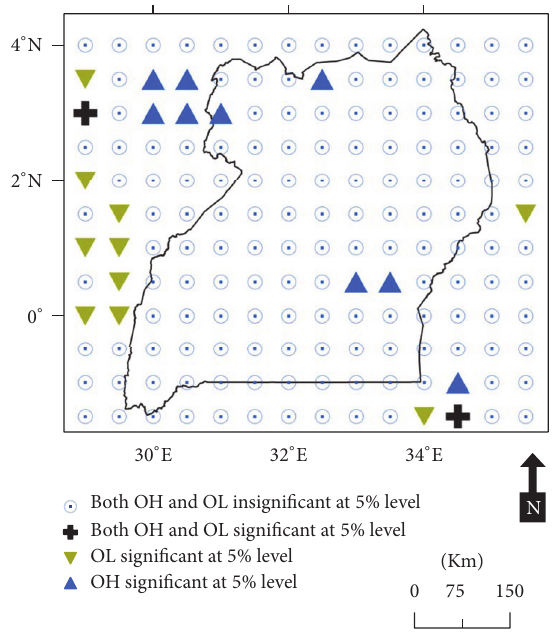
Figure 7: Spatial differences in the significance of rainfall